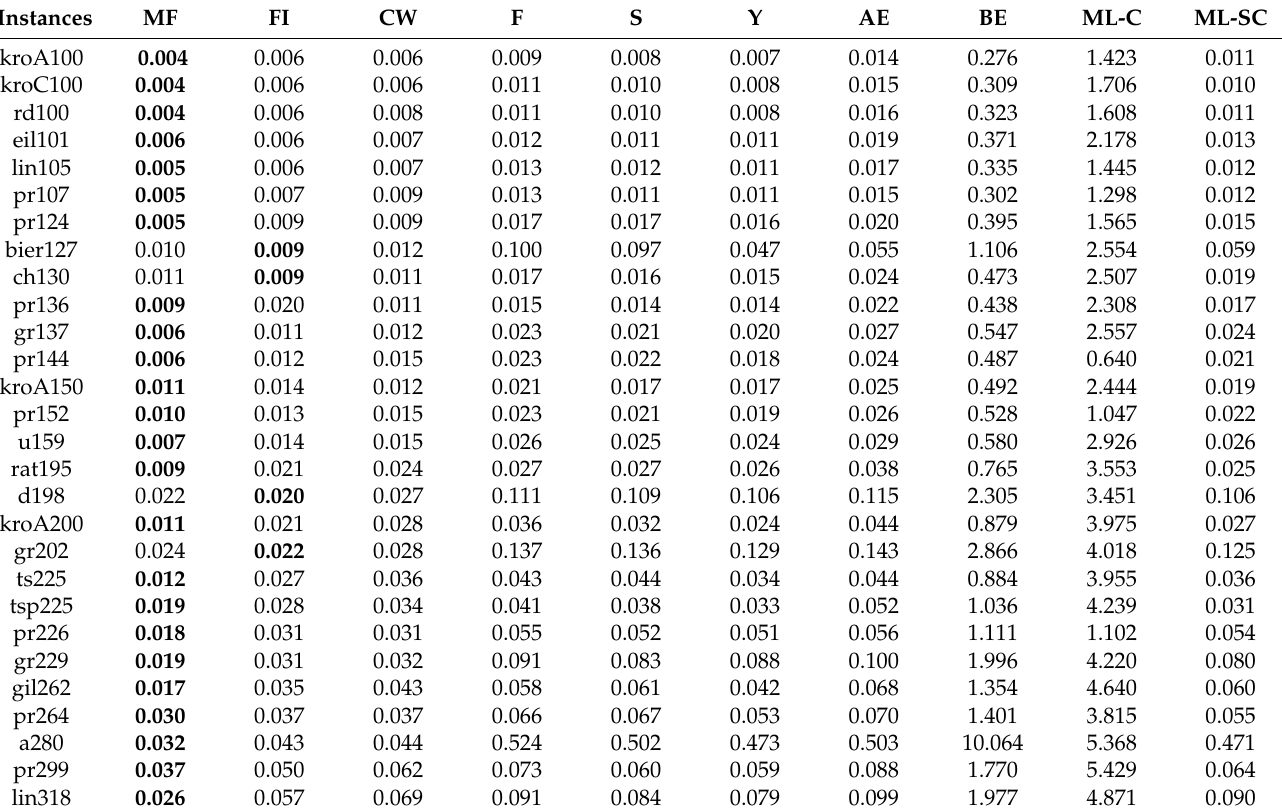
Table 4. CPU time comparison related to different greedy policies for testing TSPLIB